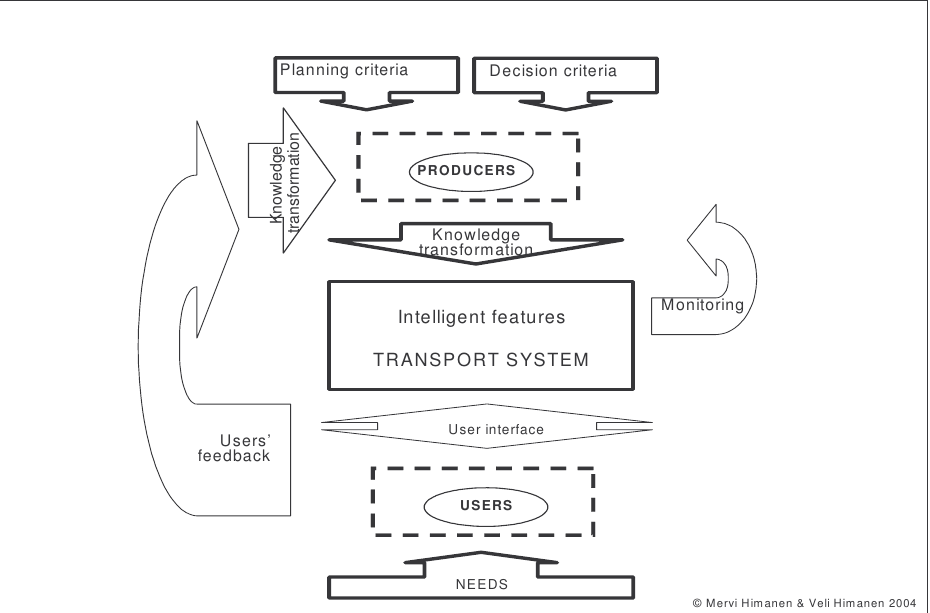
Figure 1. Transport intelligence framework Feitelson and Salomon (2004) point out that techno-economic feasibility (as a